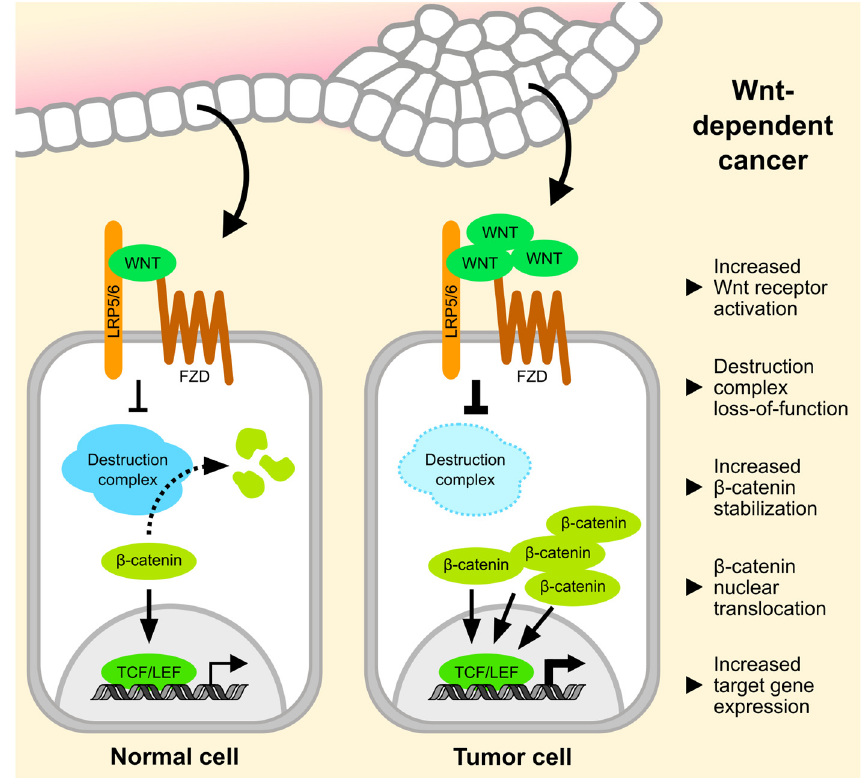
Figure 1. Overview of the canonical Wnt/ β -catenin signaling pathway. Hallmark alterations in Wnt pathway activity in Wnt-dependent cancer cells are indicated on the right. pathway activity in Wnt-dependent cancer cells are indicated on the